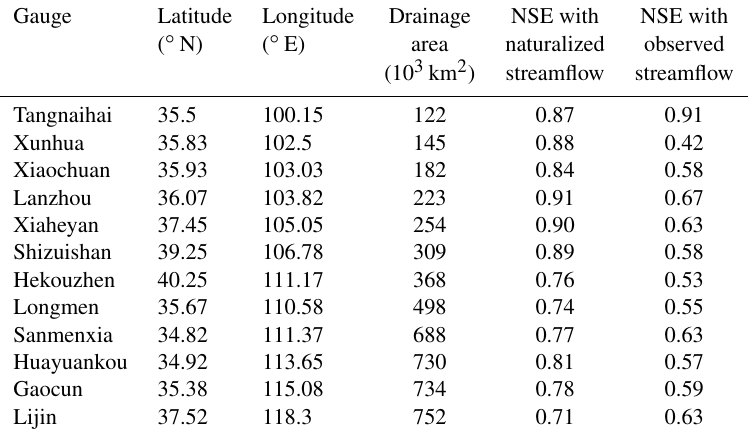
Table 2. Information at 12 hydrological gauges and the Nash–Sutcliffe efficiency (NSE) verified by using the naturalized and observed streamflow during 1982–2010. When it verified against the observed streamflow, the simulated streamflow is post-processed before calculat- ing the